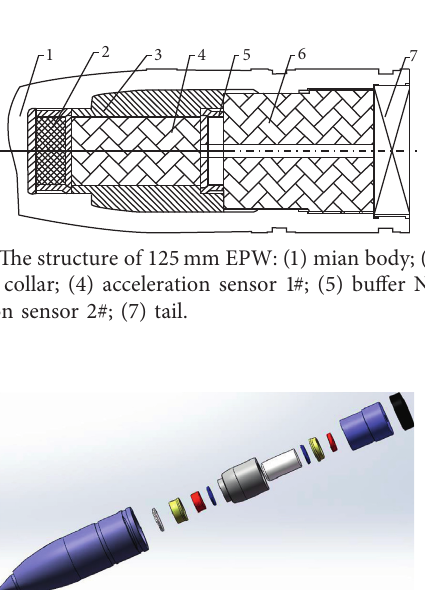
Figure 3: The composite structure.